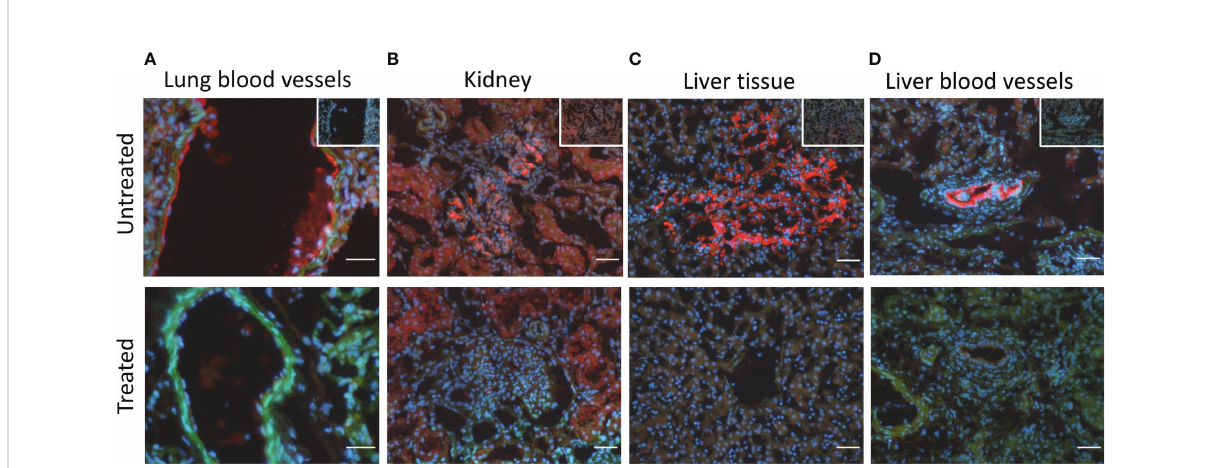
FIGURE 7 C5b-9 immuno fl uorescent staining showed C5b-9 deposition (red) (A) on the blood vessels in lung tissue in 5/7 of the untreated animals and in none of the four treated animals. (B) In kidney tissue, C5b-9 glomerular deposition was detected in 5/7 untreated and in 2/4 treated animals. (C) In the liver tissue, C5b-9 deposition was detected in 5/7 untreated and in none if the treated animals. (D) C5b-9 deposition was also detected in the liver blood vessels in the untreated but not in the treated group. One representative section from each group is shown. To facilitate the recognition of the histological structures the nuclear counterstaining (blue) and F-actin counterstaining (green) have been performed. In the upper panel, in the right upper corner, the respective ‘ no primary antibody controls ’ are illustrated. Magni fi cation bars (short white lines bottom right in all panels): 20µm (lung) and 50µm (kidney and